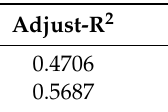
Table 8. Comparison of the OLS and GWR model estimation